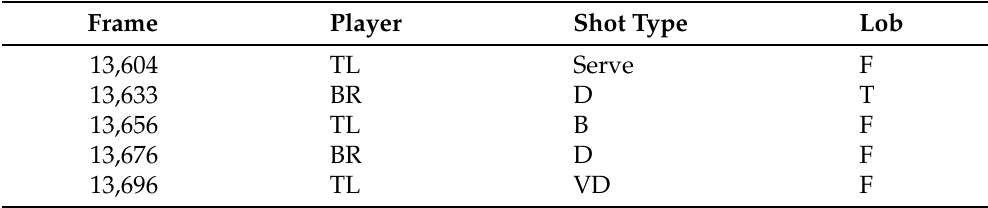
Table 2. Example of raw tabular data for padel shots. The shot type uses the classification proposed in [5]. The Lob column contains a Boolean that indicates whether the shot is a lob. Frame